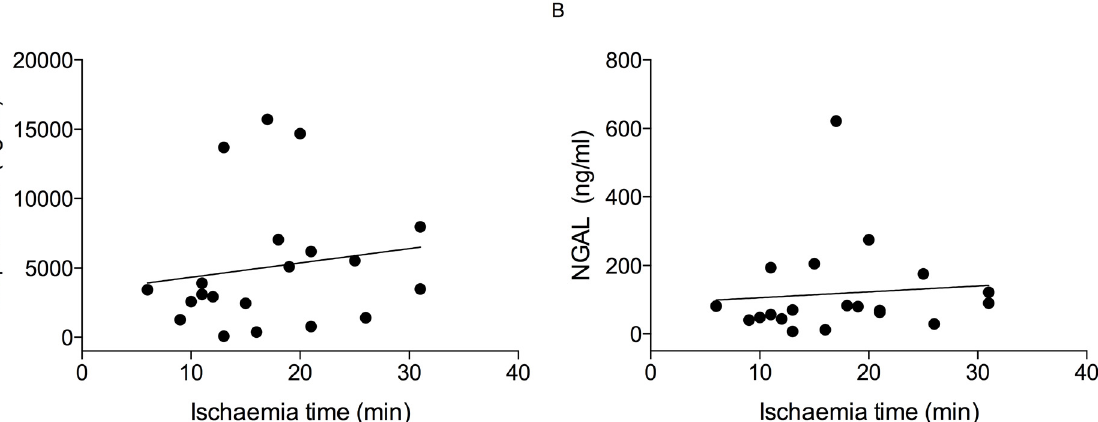
Fig 3. Association between (A) the maximum urinary calprotectin increase and ischaemic time and (B) the maximum urinary NGAL increase and ischaemic time in Group 1 (NSS with renal ischaemia) in a linear regression model, as assessed by Spearman ’ s correlation test. Regression lines are plotted. Linear regression model: A: R = 0.16, B = 103.61 (95% CI -219.96 – 427.19), p = 0.51; B: R = 0.09, B = 1.71 (95% CI -7.88 – 11.31), p = 0.71. Spearman ’ s correlation: A: R = 0.29 (95% CI -0.19 – 0.66), p = 0.21; B: R = 0.26 (95% CI -0.22 – 0.64), p = 0.26. NSS, nephron sparing surgery for kidney tumours; B, regression co-efficient, slope of the regression line; R, correlation co-efficient; CI, confidence